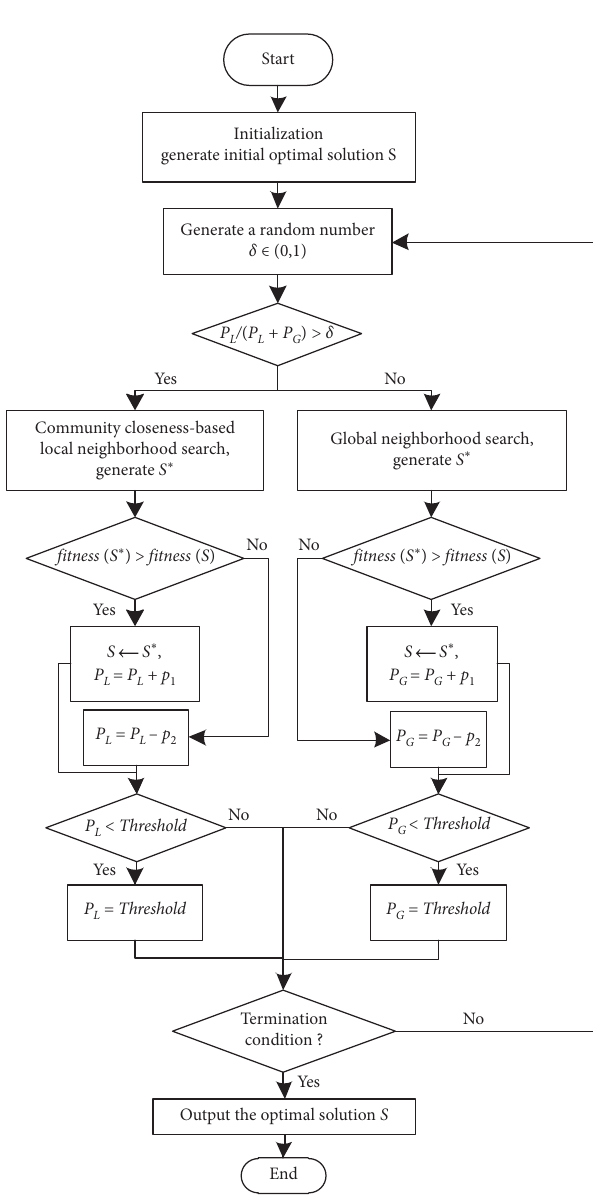
Figure 4: Flowchart of the proposed